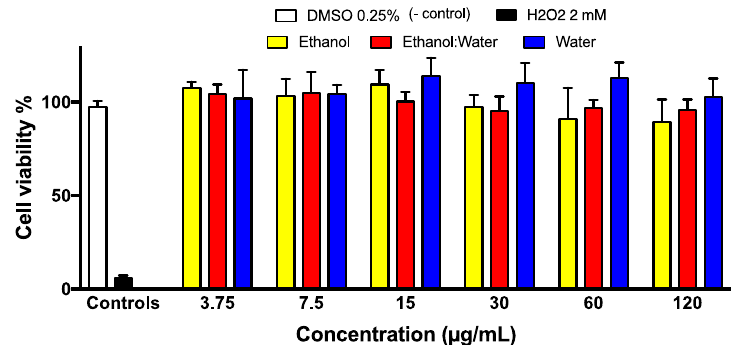
Figure 8. Cytotoxicity study of LT extracts against Hs27 cells. The non-cancerous Hs27 fibroblasts cells were incubated for 24 h after treatment with each of the three LT extracts at various concentrations (3.75–120 µM). DMSO and H 2 O 2 were used as negative and positive controls, respectively. Each bar represents the average of three replicates.